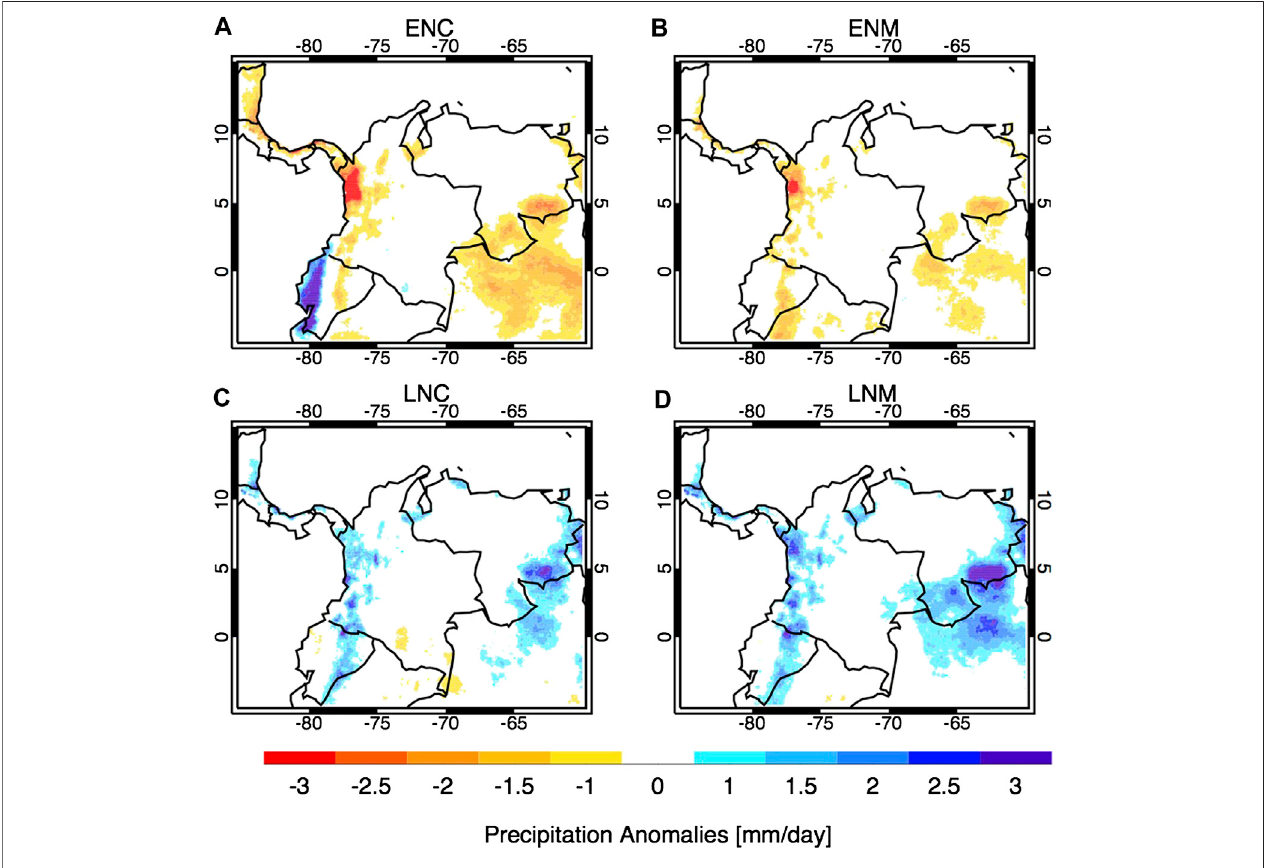
FIGURE7| Precipitationanomaliesinthenorthtropical Andes during (A) Canonical ElNiño(ENC), (B) ElNiñoModoki(ENM), (C) CanonicalLaNiña(LNC),and (D) La Niña Modoki (LNM) for DJF according to CHIRPS data. ENSO years are considered according to Navarro-Monterroza et al. (2019) for the period 1981 – 2015.